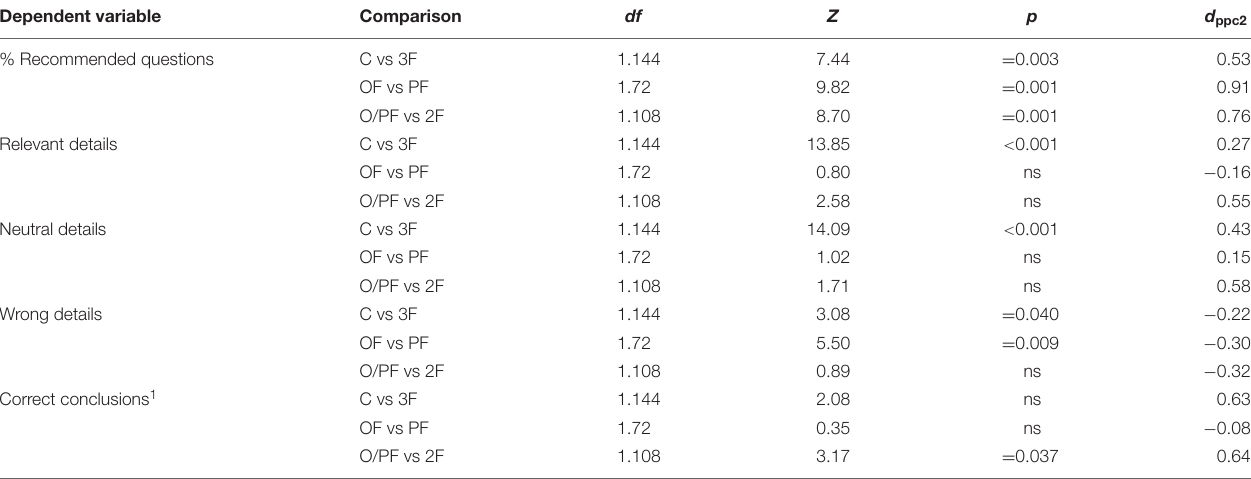
TABLE 3 | Detailed results of the planned comparisons on the dependent